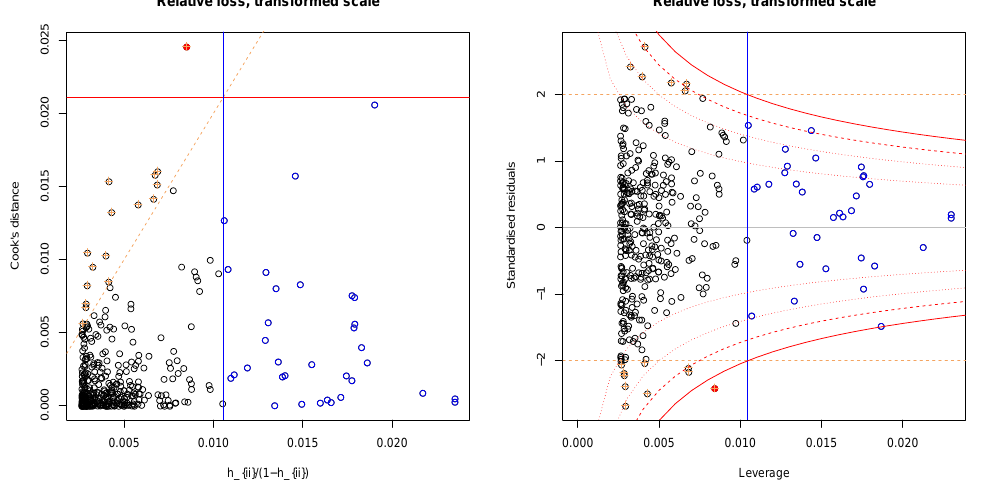
Figure A2. Leverage (X-axis) vs Cook’s distance ( left ) and standardised residuals ( right ) for the relative loss model on the vertical axis. Blue borders indicate high leverage points, red filled circles indicate high values for Cook’s distance and the orange dashed lines indicate the borders to the definition of large residuals. One outlier (Bonferroni outlier test) is not shown in the plot.